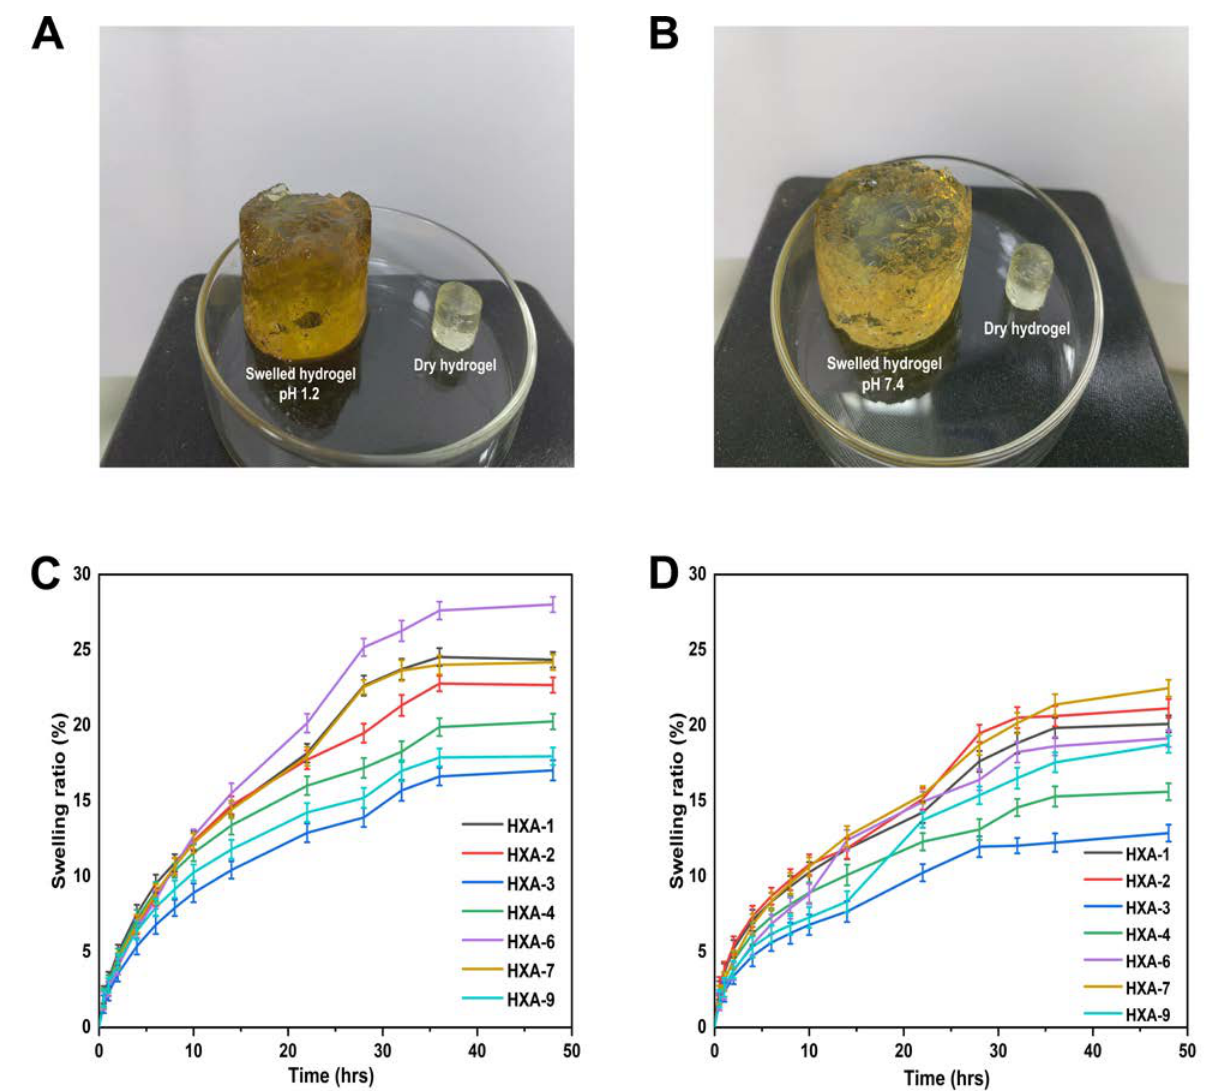
Figure 9. Physicochemical properties of hydrogels when swollen at different pH levels, such as ( A ) pH 1.2 and ( B ) pH 7.4. Hydrogel swelling curves at pH 1.2 ( C ) and pH 7.4 ( D ).